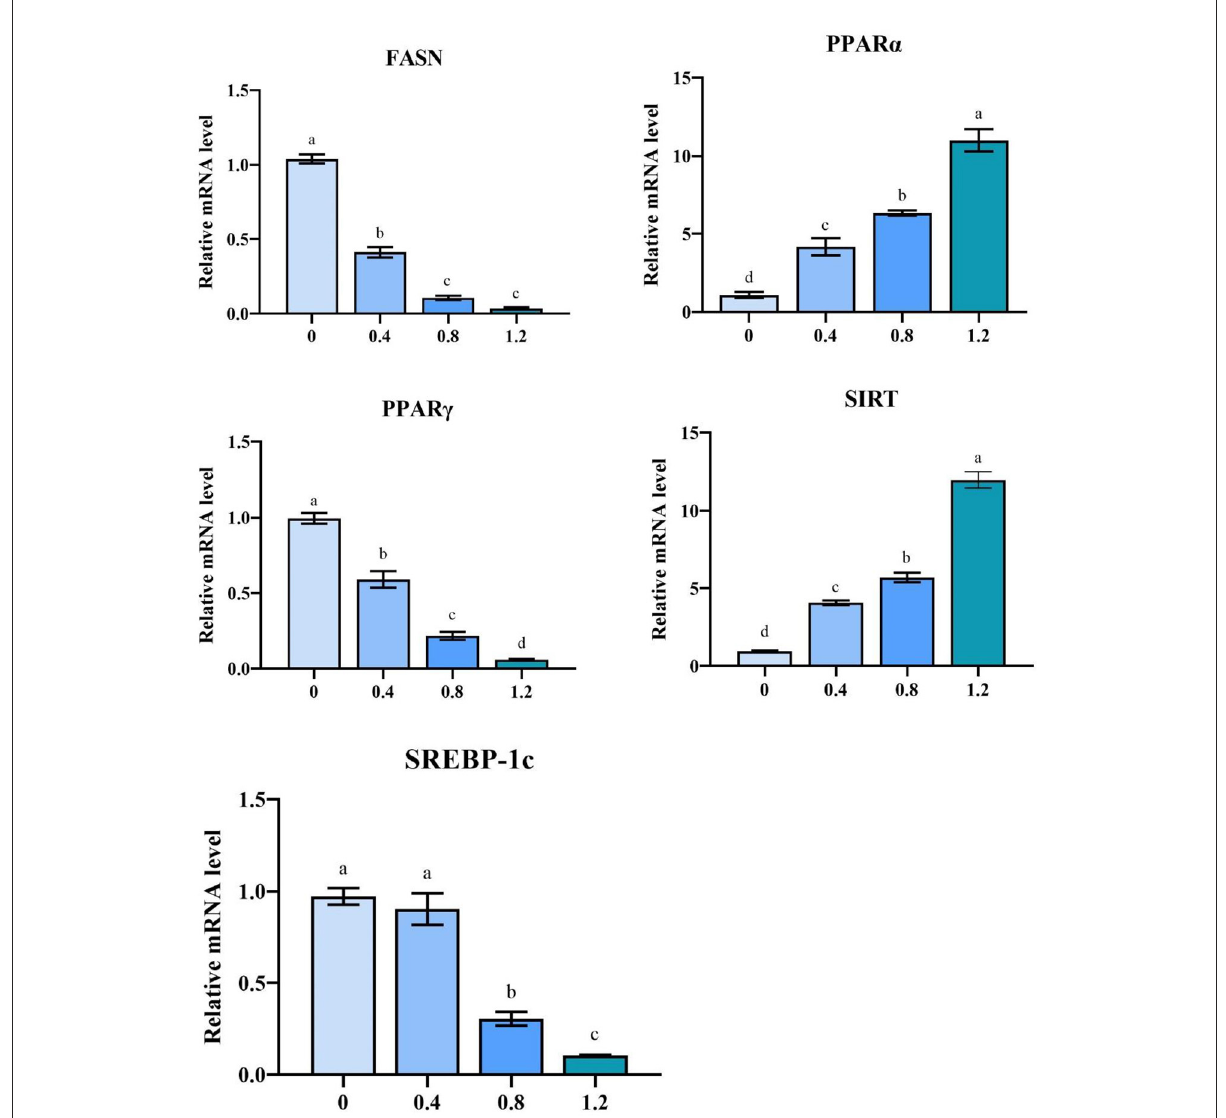
FIGURE1 The effect of MLE on the mRNA expression of the laying hen hepatic (FASN, SIRT, PPAR γ , SREBP-1c and PPAR α ) genes (mean ± MSE). Columns with different superscript letters are significantly different ( P <